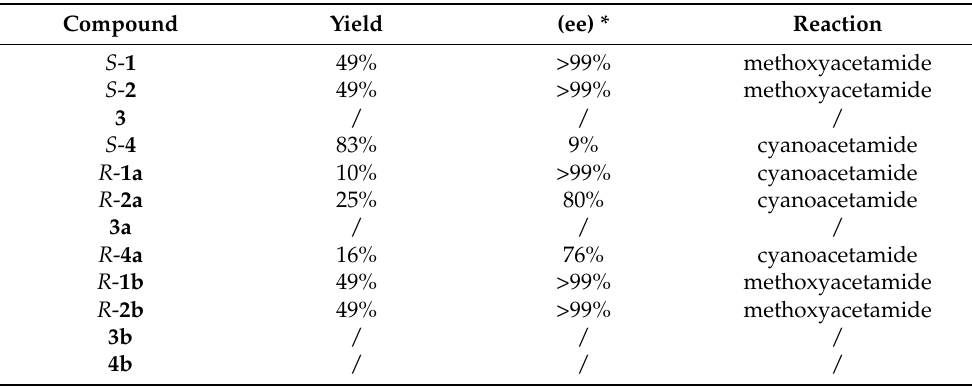
Table 2. Data for lipase-catalyzed amidation